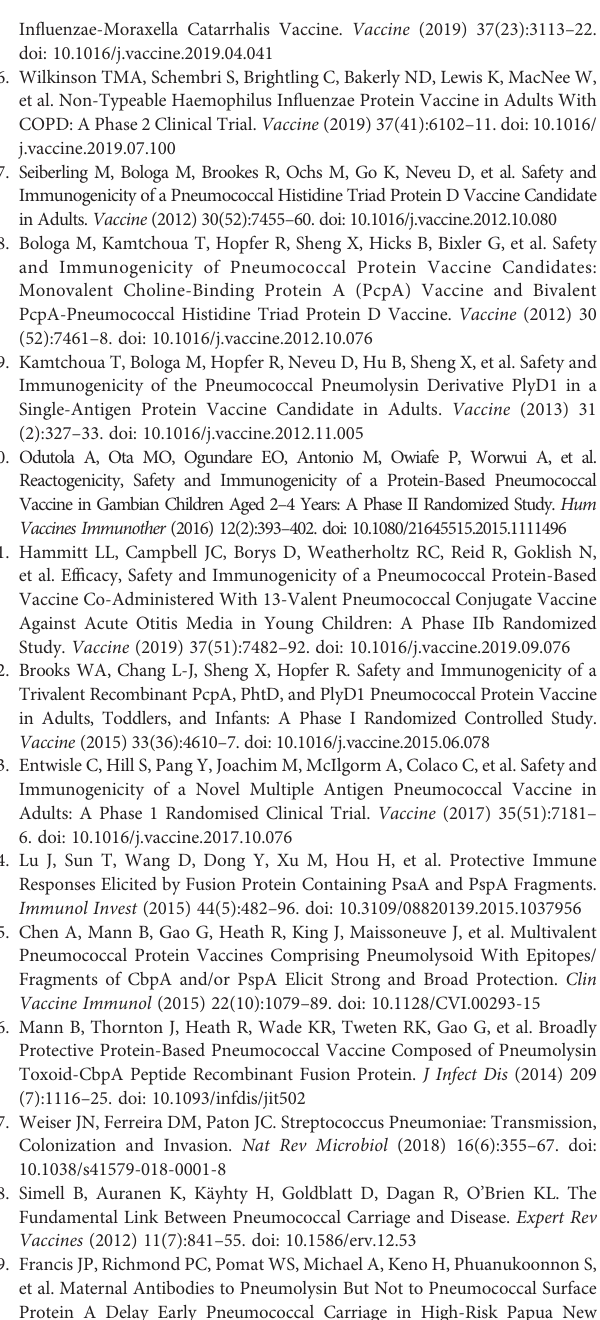
carriage ( S. pneumoniae DNA detected above the assay limit of detection) is outlined underneath the graph. *p-value < 0.05. Supplementary Figure 2 | NTHi density in children carrying NTHi up to 2 years of age. NTHi nasopharyngeal density in swabs from children taken at 1, 4, 9, 10, 23 and 24 months of age. Data are presented for children that were colonised with NTHi as determined by qPCR. Each point represents an individual child, and the horizontal bars depict the median geometric mean density of DNA concentration in µg/mL in qPCR-positive samples. The number and percentages of children who were positive for NTHi carriage (NTHi DNA detected above the assay limit of detection) is outlined underneath the graph. *p-value <